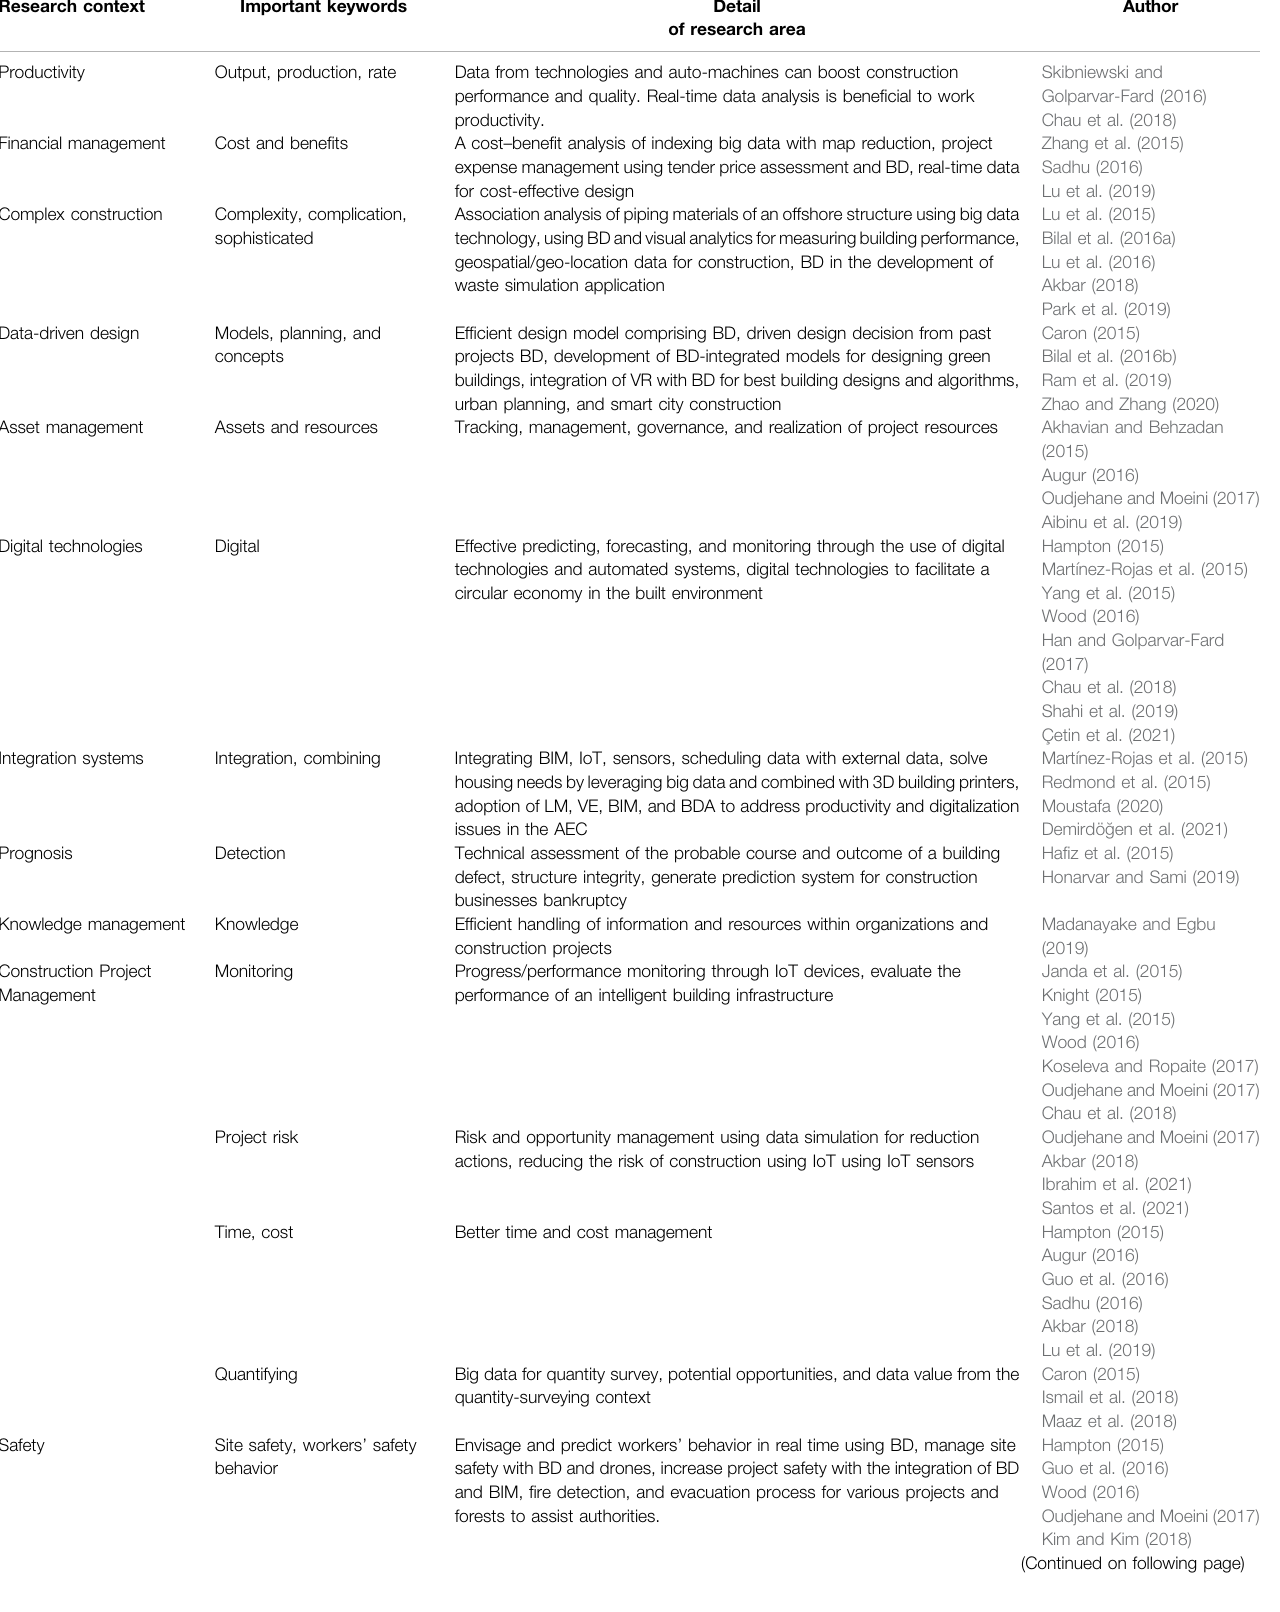
TABLE 1 | Detailed context of the big data integration research area from various